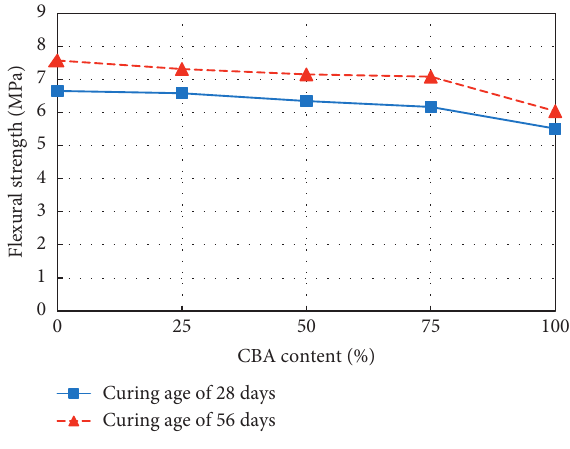
Figure 8: Flexural strength test